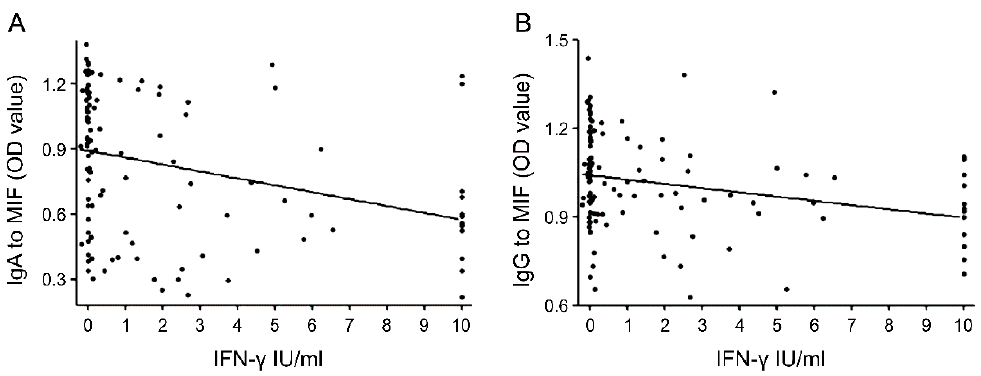
Figure 4. Correlation between the level of interferon-gamma and the levels of serum immunoglobulin (Ig)A (r = − 0.325, p < 0.0001) ( A ) and IgG (r = − 0.295, p = 0.001) ( B ) against MIF.